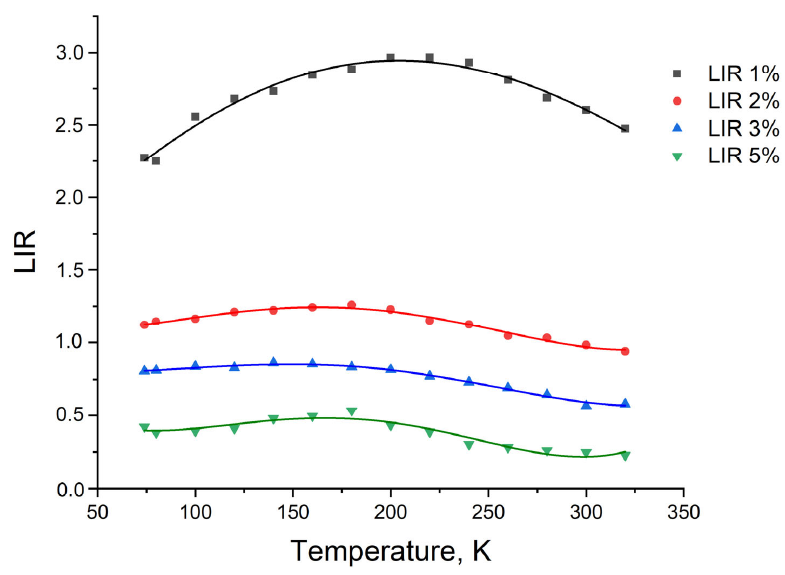
Figure 7. The LIR curves for I (Nd 3+ , 4 F 3/2 – 4 I 9/2 , ~866 nm) and I (Yb 3+ , 2 F 5/2 – 2 F 7/2 , ~980 nm) lumines ‐ cence peaks.